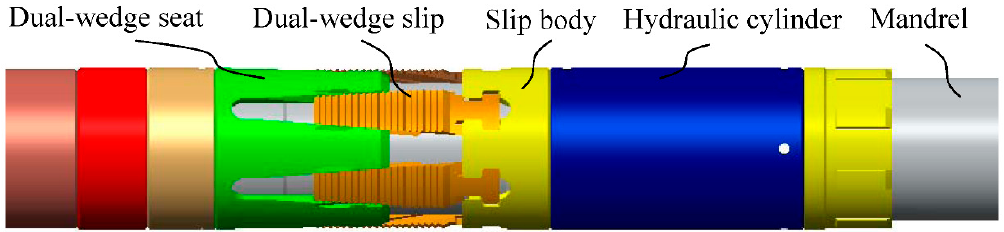
Figure 2. Liner hanger with dual-wedge slips.